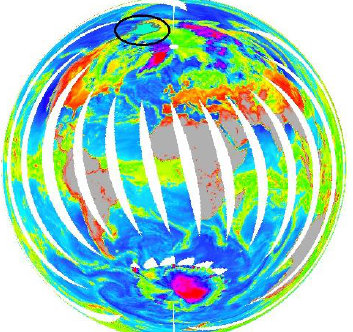
Figure 3. SSMI passive microwave ESA gridded data. We shows Alaska using black elliptic here and in cyan